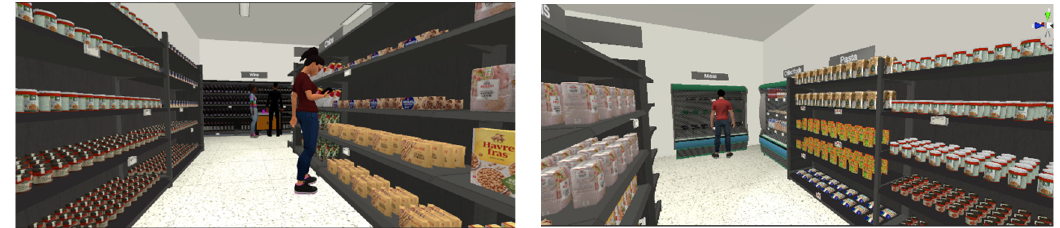
Figure 2. Pictures showing an example of the participant perspective in the VR